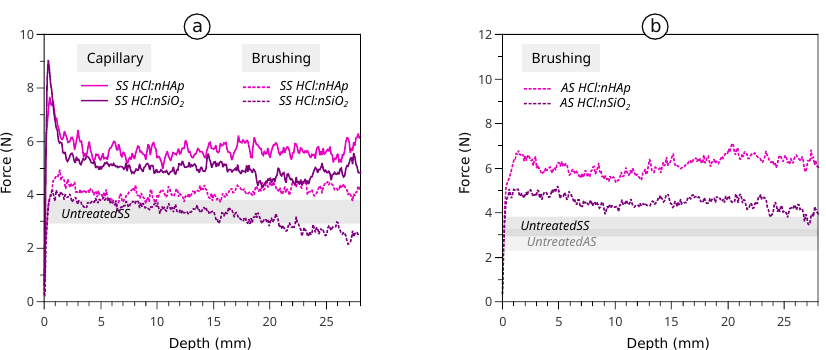
Figure 7. Drilling resistance average profiles of the treatment by brushing with HCl:nHAp and HCl:nSiO 2 on ( a ) sound stone (SS) and ( b ) aged stone (AS) samples .